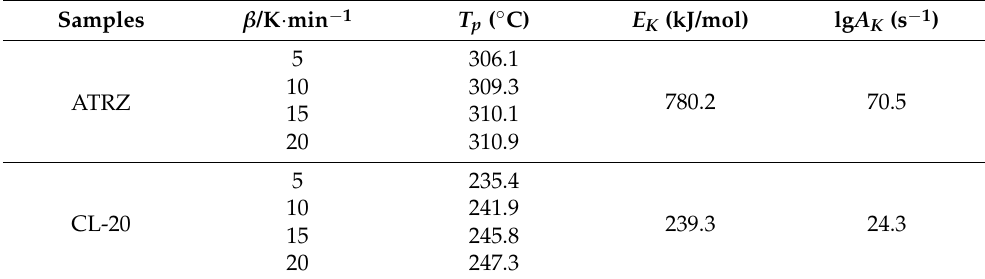
Figure 5. Kissinger method fitting curves. Kissinger method of ATRZ ( a ) and Kissinger method of CL-20 ( b ). Table 1. Peak temperatures and kinetics parameters of different pyrolysis systems obtained by Kissinger.